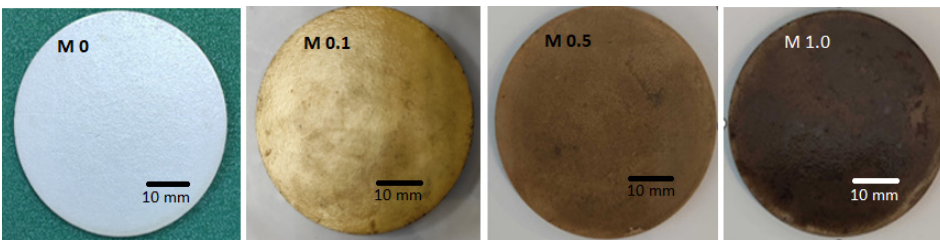
Figure 2. XRD spectrum of Ag-CuO NPs (* represents Ag peaks).